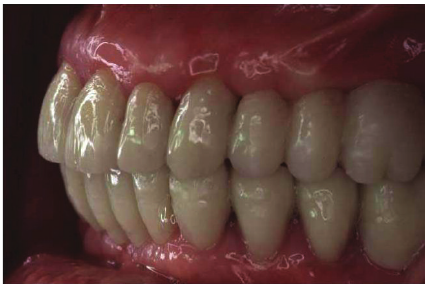
Figure 10: Osseous resective surgery in the maxillary anterior sextant.